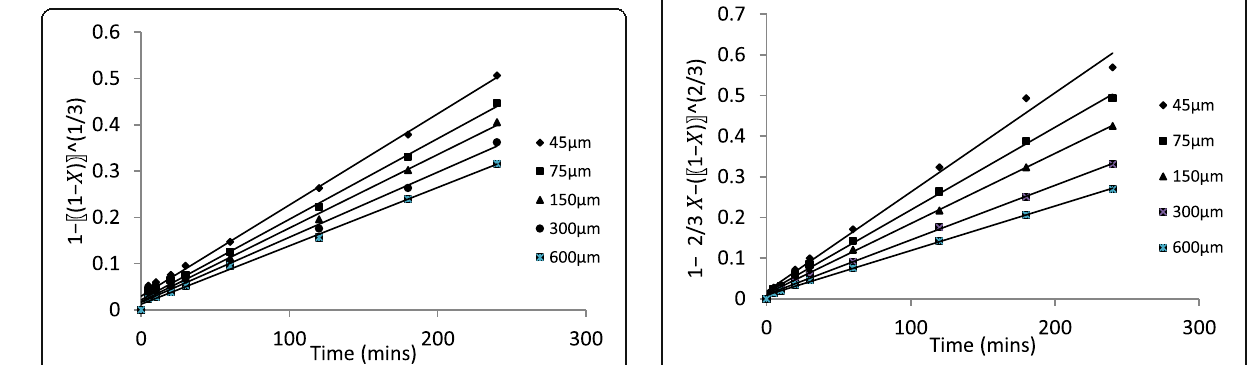
X − ð 1 − X Þ 2 3 versus dissolution time at different Fig. 6 Plot of 1 − 2 3 ore particle